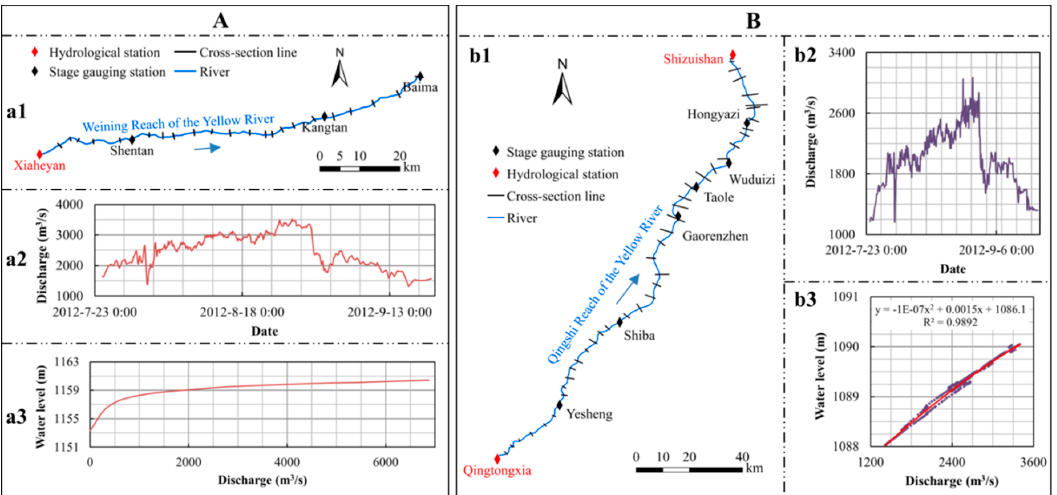
Figure 3. Control conditions of the river hydrodynamic model in the Weining Reach ( A ) and Qingshi Reach ( B ) of the NRYR: ( a1 ) Modeling scope of the Weining Reach; ( a2 ) upstream inflow process at Xiaheyan station; and ( a3 ) water level–flow relationship in the downstream outflow cross-section of the Weining Reach. ( b1 ) Modeling scope of the Qingshi Reach; ( b2 ) upstream inflow process at Qingtongxia station; and ( b3 ) water level–flow relationship in the downstream outflow cross-section of the Qingshi Reach.